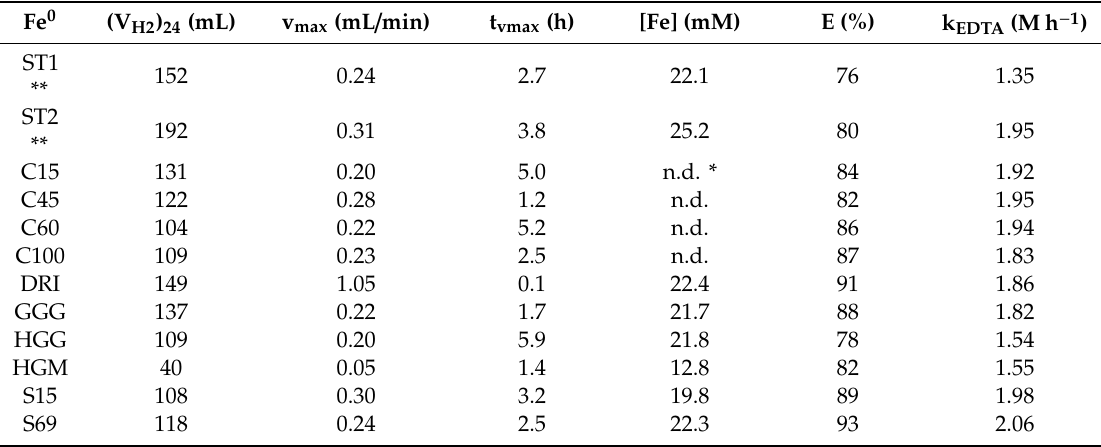
Table 4. Summary of the results of hydrogen (H 2 ) production in H 2 SO 4 (pH 2) and percentage removal (E) of uranium by Fe 0 materials in tap water. (V H2 ) 24 is the H 2 volume after 24 h; v max is the maximum H 2 production rate at time t vmax ; [Fe] is the aqueous iron concentration at the end of the H 2 production experiment (28 h). k EDTA is the corrosion rate in a 2 mM EDTA solution